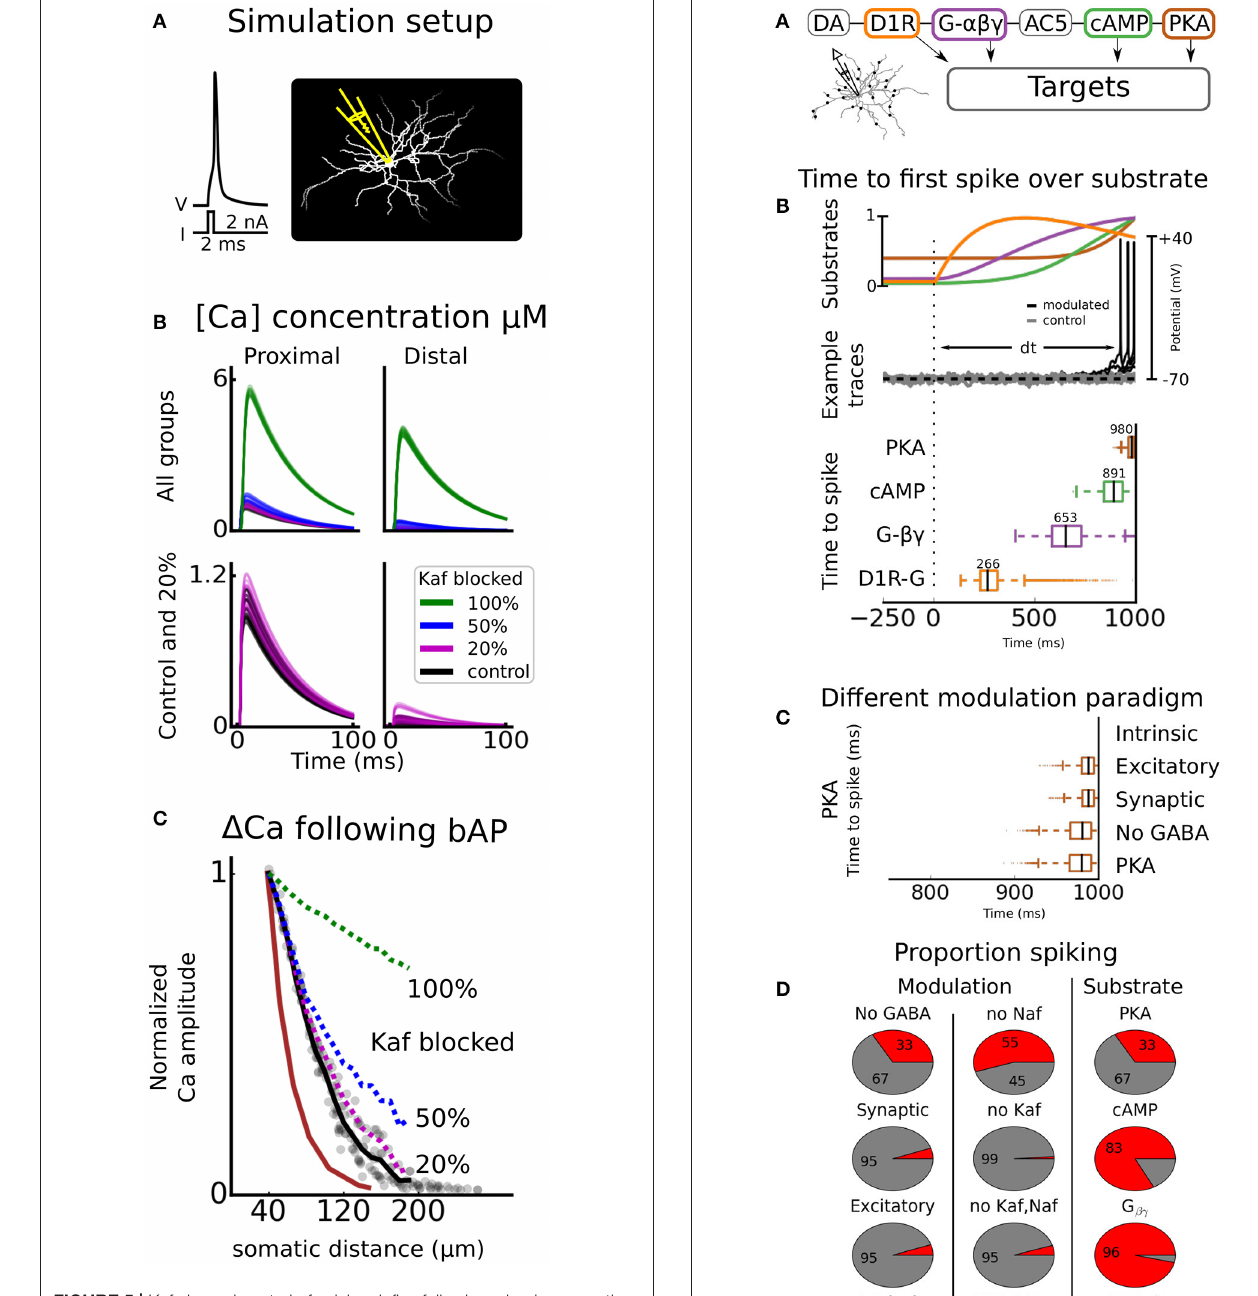
Frontiers in Neural Circuits |